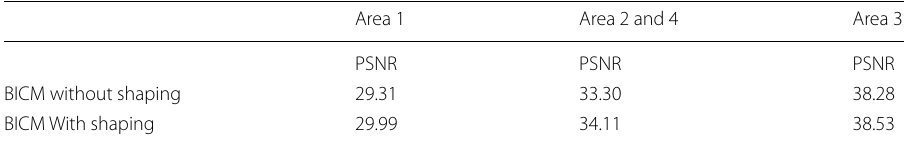
Table 4 Average performance of Monarch image in terms of PSNR (dB) with and without shaping